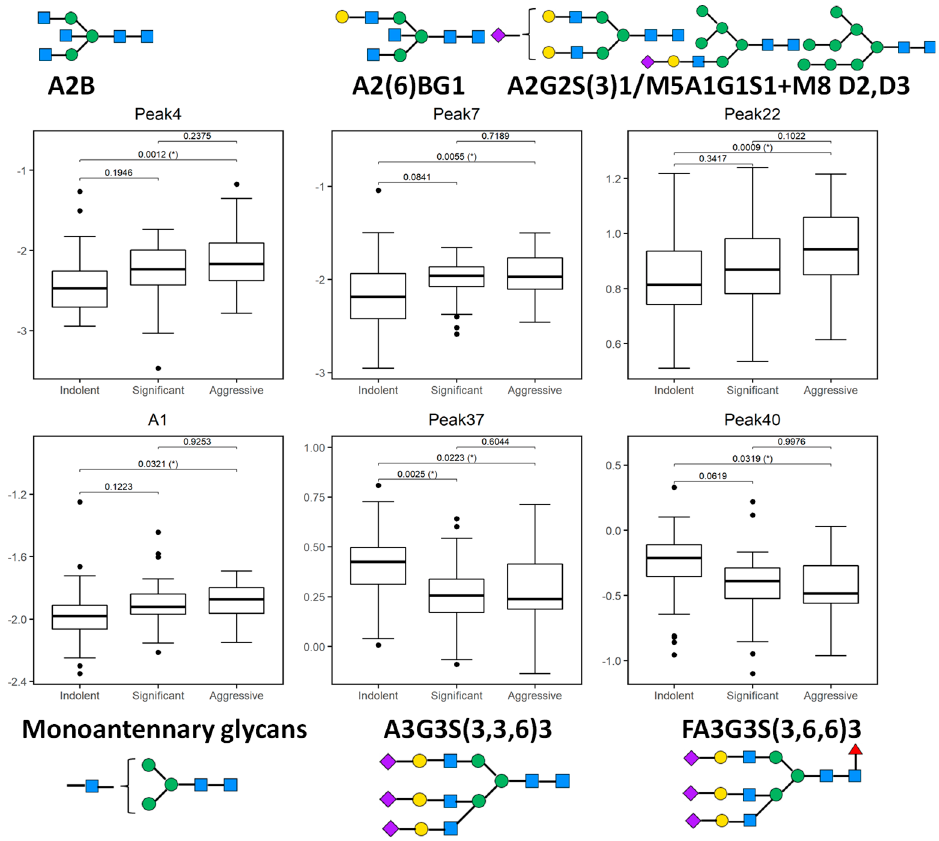
Figure 2. Boxplots of 5 glycosylation peaks and one feature which exhibited significant differences across 3 patient groups (indolent, significant, and aggressive) from the Irish prostate cancer research consortium (PCRC) cohort. The boxes represent the 25th and 75th percentiles with the median indicated. The lower and upper quartiles are shown as horizontal lines either side of the rectangle. The top and the first panel of the bottom row show peaks (and one feature) that significantly increase as disease progresses; otherwise the bottom row shows peaks that significantly decrease as disease progresses. From left to right, the given p -values relate to tests of di ff erences between indolent and significant, indolent and aggressive, and significant and aggressive disease types, respectively, as indicated by the brackets at the top of each plot. p -values that are significant at the 5% level are highlighted with